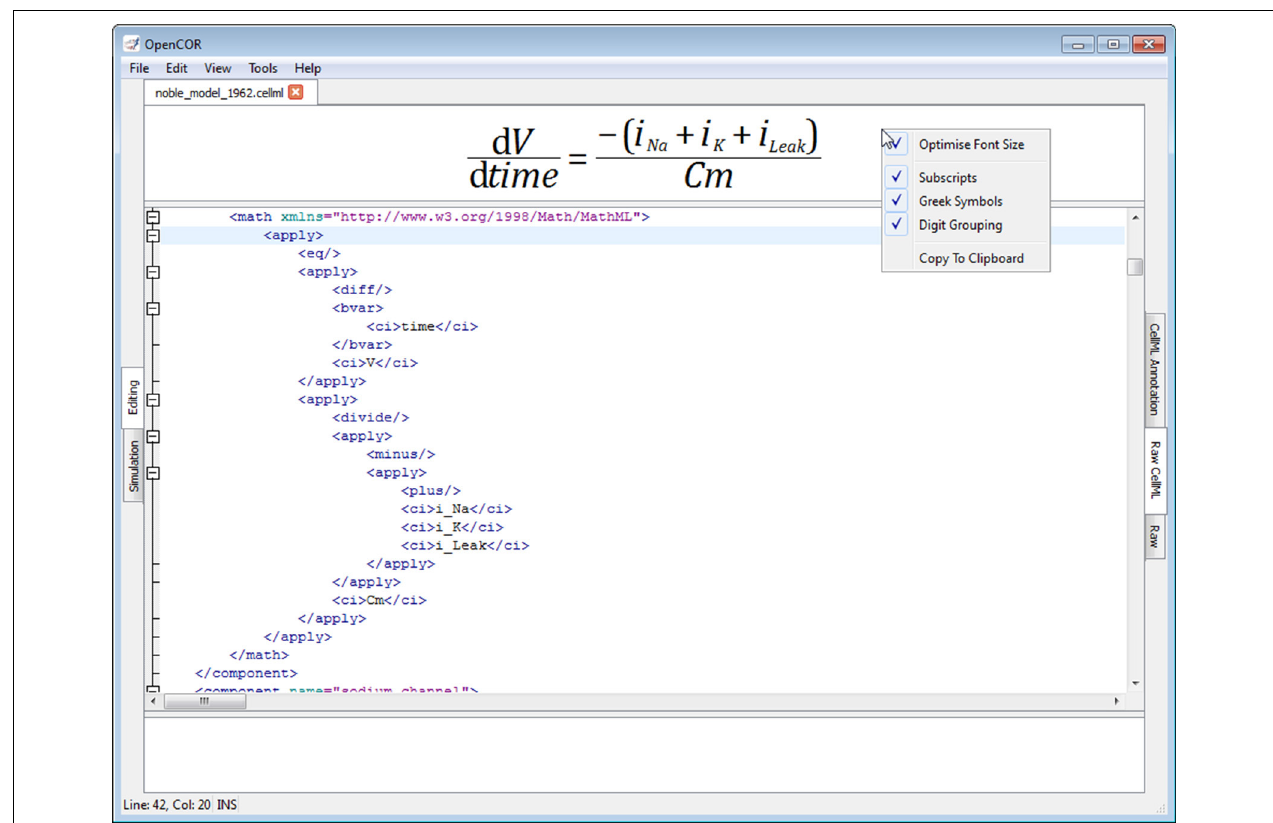
FIGURE 6 | Raw CellML view. The Raw CellML view builds on the Raw view ( Figure 5 ) by adding syntax highlighting for CellML files. For user convenience, mathematical equations are rendered above the editor and in real-time. CellML files can also be validated, resulting in a list of errors/warnings, if needed.